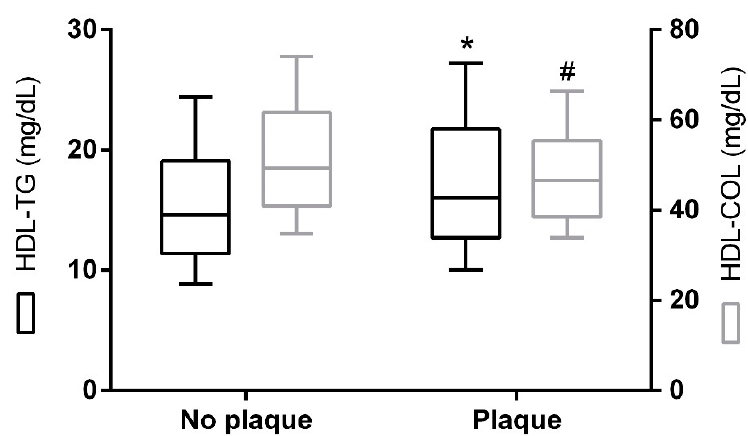
Figure 3. HDL-TG and HDL-C levels according to atherosclerotic plaque. The data are presented as box-plot. p values for group comparison are reported for the Mann–Whitney U test. * p < 0.05, HDL-TG; # p = 0.05, HDL-C. No plaque ( n = 211); plaque ( n = 103).